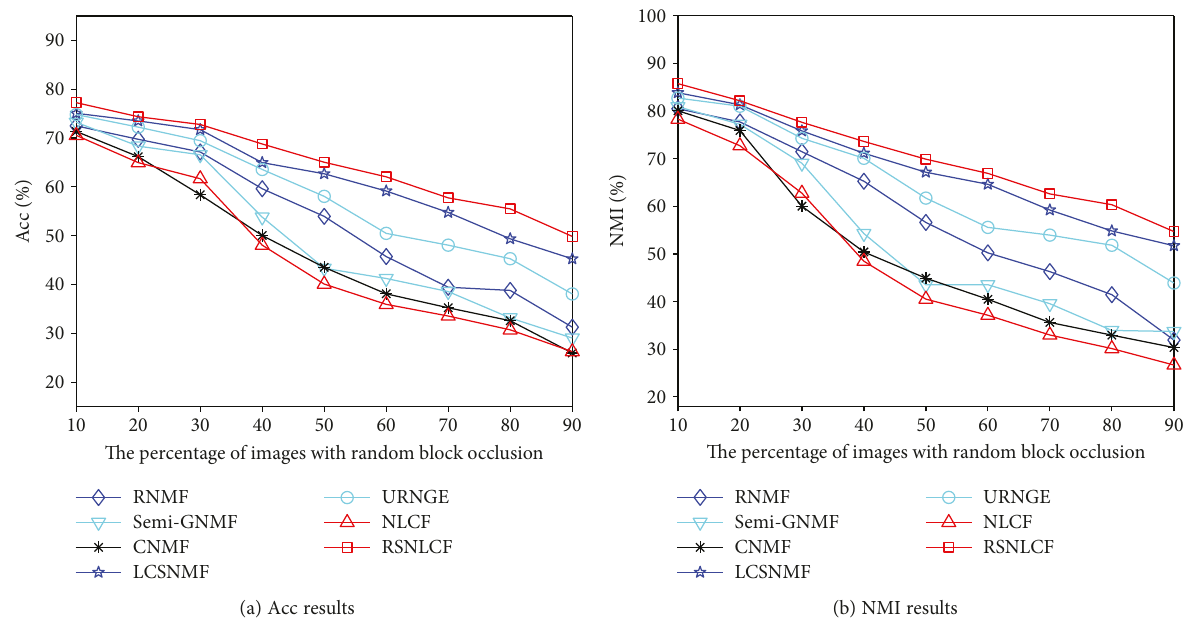
Figure 4: Clustering Acc and NMI curves of the compared methods on percentages of corrupted images with random block occlusions for the ORL